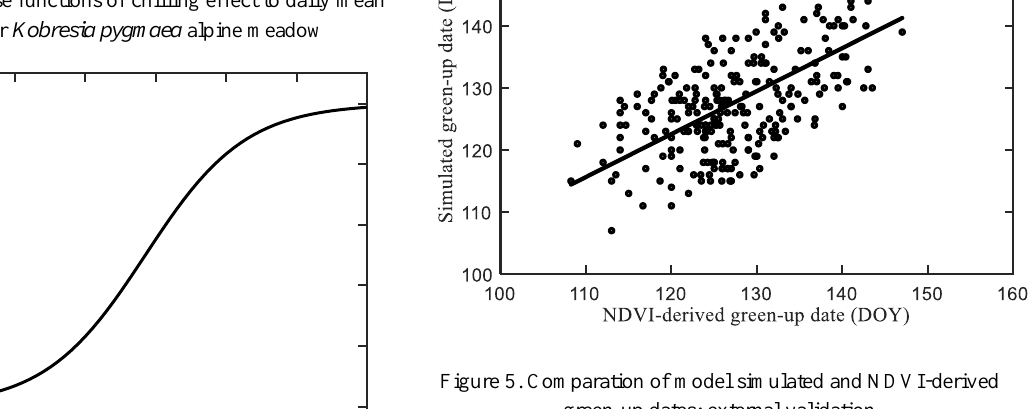
Figure 5. Comparation of model simulated and NDVI-derived green-up dates: external